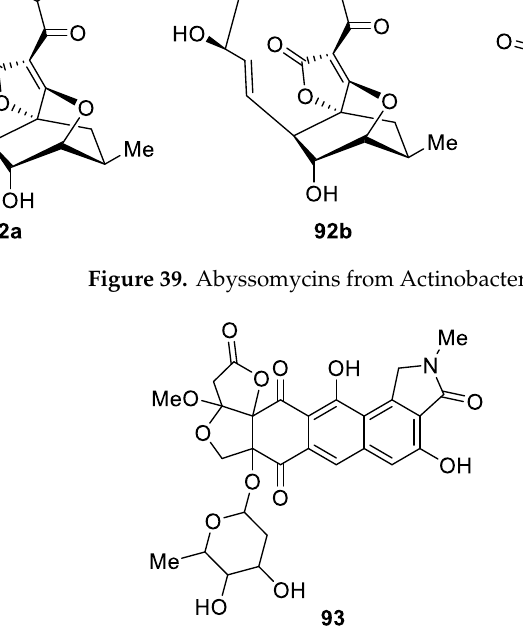
Figure 40. Antibacterial and antitumor compound lactonamycin Z isolated from Streptomyces sanglieri .